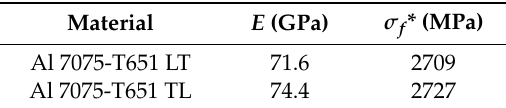
Table 7. Values of EMC parameters.